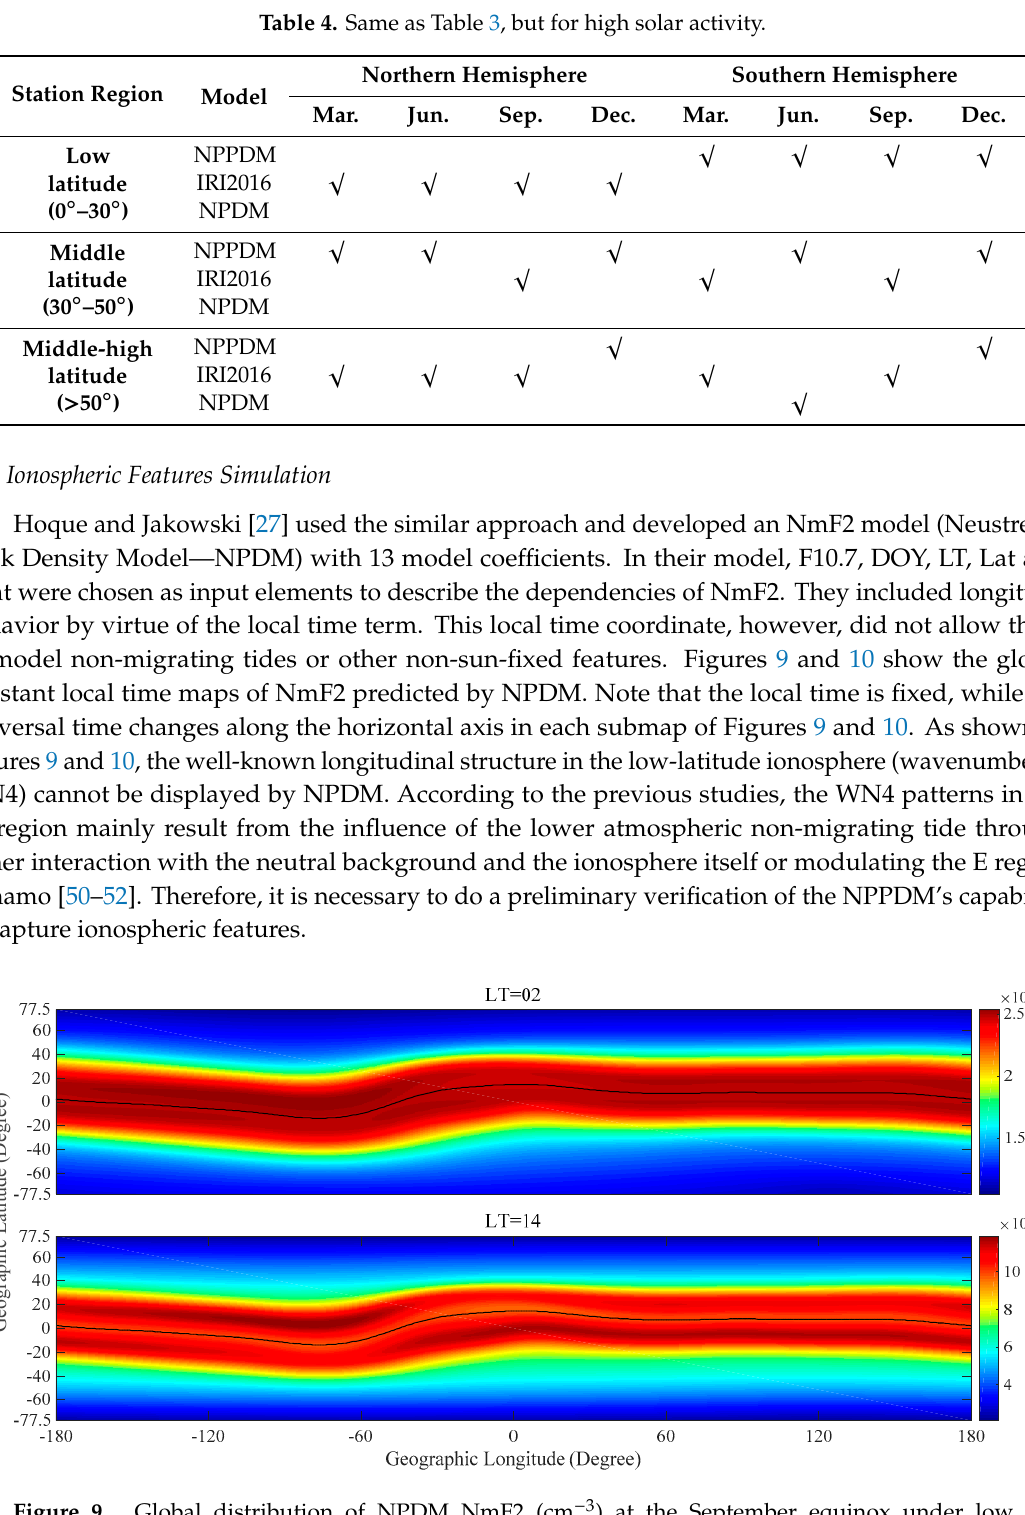
3 cm − ) at the September equinox under low (F10.7=80 sfu)